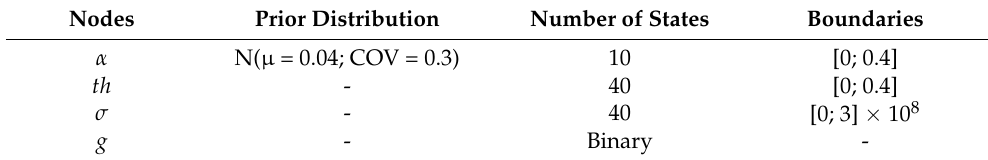
Table 3. Discretization of nodes in the